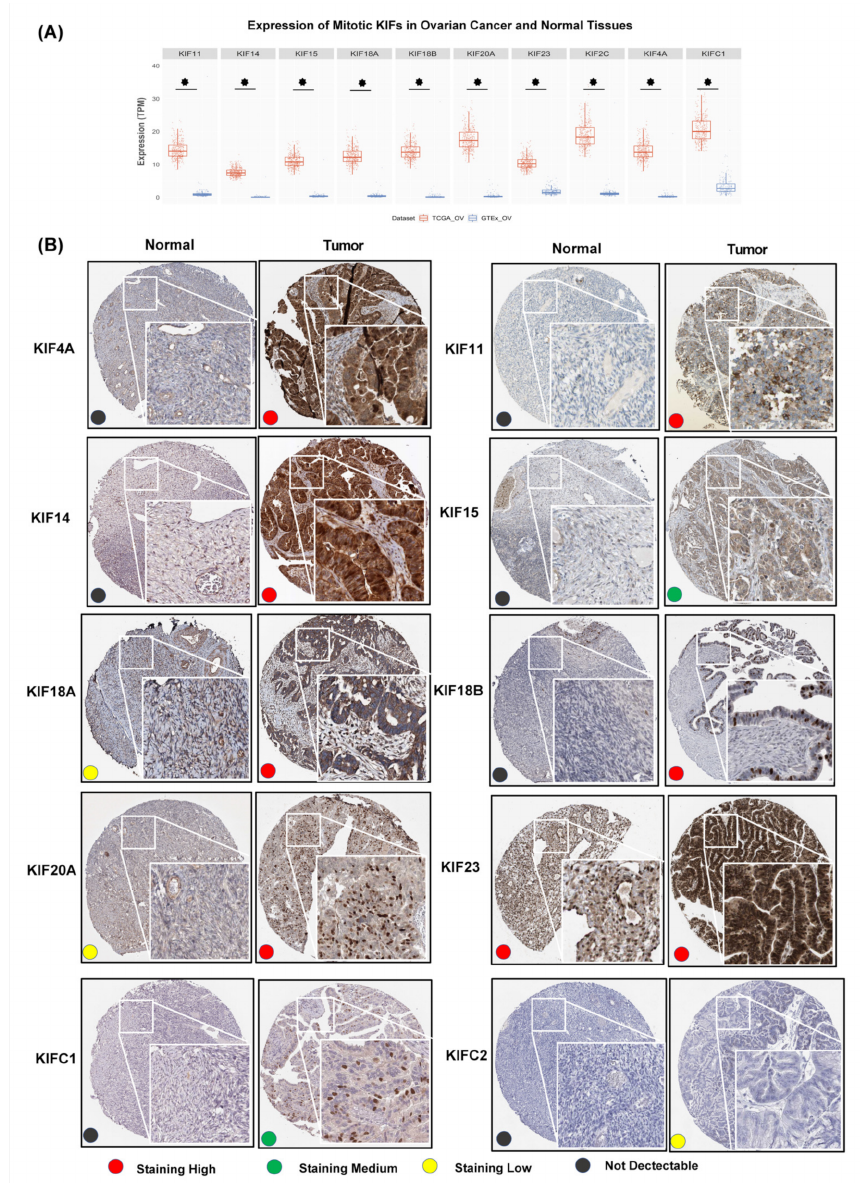
Figure 3. Expression profiles of mitotic kinesin superfamily in OC. ( A ) mRNA levels of ten overex- pressed mitotic KIFs (4A, 11, 14, 15, 18A, 18B, 20A, 23, C1, and 2C) in ovarian cancer and normal ovarian tissues from TCGA-OV ( n = 426) and GTEx-OV ( n = 88) dataset, respectively. TPM, transcripts per million; * p < 0.05; ( B ) Immunohistochemistry images of ten overexpressed mitotic KIFs in ovarian cancer and normal ovarian tissues from Human Protein Atlas. Red, green, yellow, and black dots present high, medium, low staining, and not detectable, respectively. KIFs (4A, 11, 14, 15, 18B, C1, and 2C) protein were not expressed in normal ovarian tissues; KIF18A and KIF20A have low expression in cytoplasmic/membranous. KIF23 has relative high expression in cytoplasmic/membranous. KIFs (4A, 11, 14, 18A, 18B, 20A, and 23) have high expression in OC tissues, and KIF15 and KIFC1 have medium expression, whereas KIF2C expression level is relatively low in OC